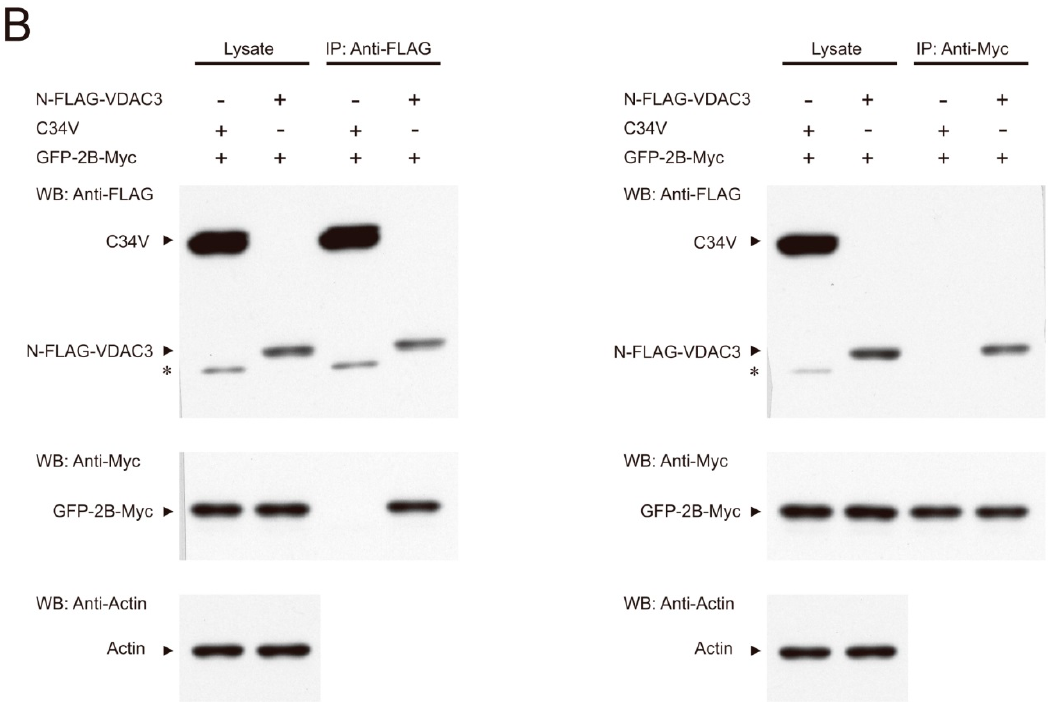
Figure 3. Interaction between 2B and VDAC3. ( A ) Vero cells were transfected with GFP-2B-Myc expression vector (or the one expressing the control protein GFP-Myc) and N-FLAG-VDAC3 expression vector. Cell lysate was prepared for immunoprecipitation ( IP ) with anti-Myc (left panel) or anti-FLAG (right panel) antibody. The cell lysate and immunoprecipitate were analyzed by Western blotting with antibody to anti-Myc epitope tag, anti-FLAG epitope tag, or anti-actin (for total cell lysate). ( B ) Vero cells were transfected with N-FLAG-VDAC3 expression vector (or the expression vector encoding the FLAG-tagged C34V control protein) in addition to GFP-2B-Myc expression vector. Cells were lysed for immunoprecipitation ( IP ) with anti-FLAG (left panel) or anti-Myc (right panel) antibody. The cell lysate and immunoprecipitate were analyzed by Western blotting with antibody to anti-Myc epitope tag, anti-FLAG epitope tag, or anti-actin (for total cell lysate). The asterisk (*) indicates a degradation product of C34V. A representative result of three experiments is shown